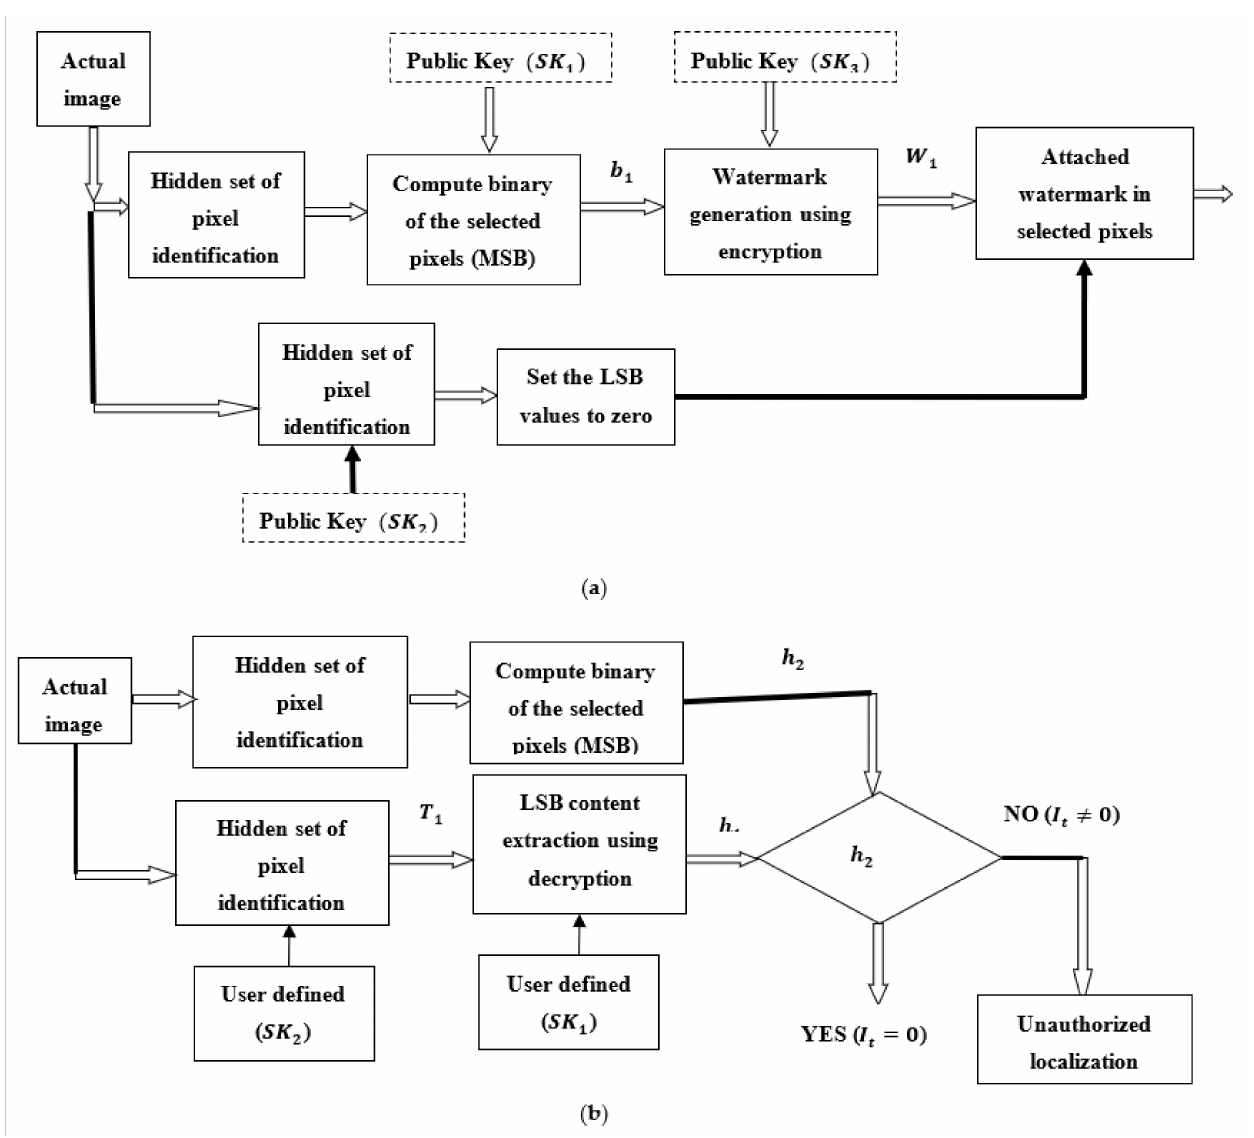
Figure 6. Image authentication using robust watermarking; ( a ) verifier generator; ( b ) authenticity